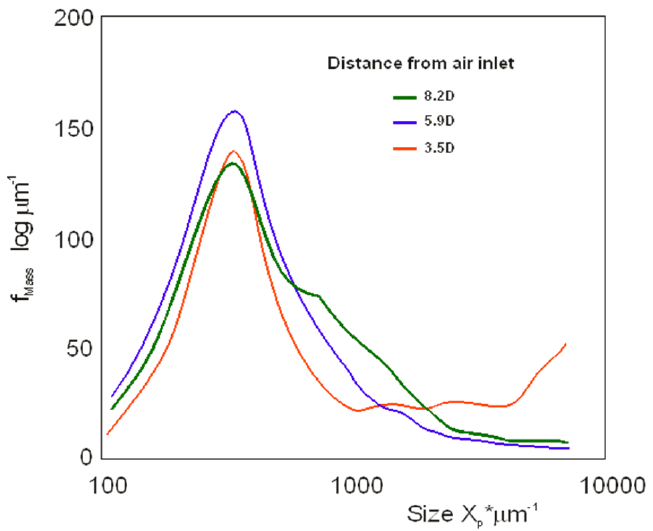
Figure 4. Corrected Comparison of the product mass based size distribution obtained under dif- Figure 4. Comparison of the product mass based size distribution obtained under different nozzle ferent nozzle locations Ref. [7]. locations Ref.